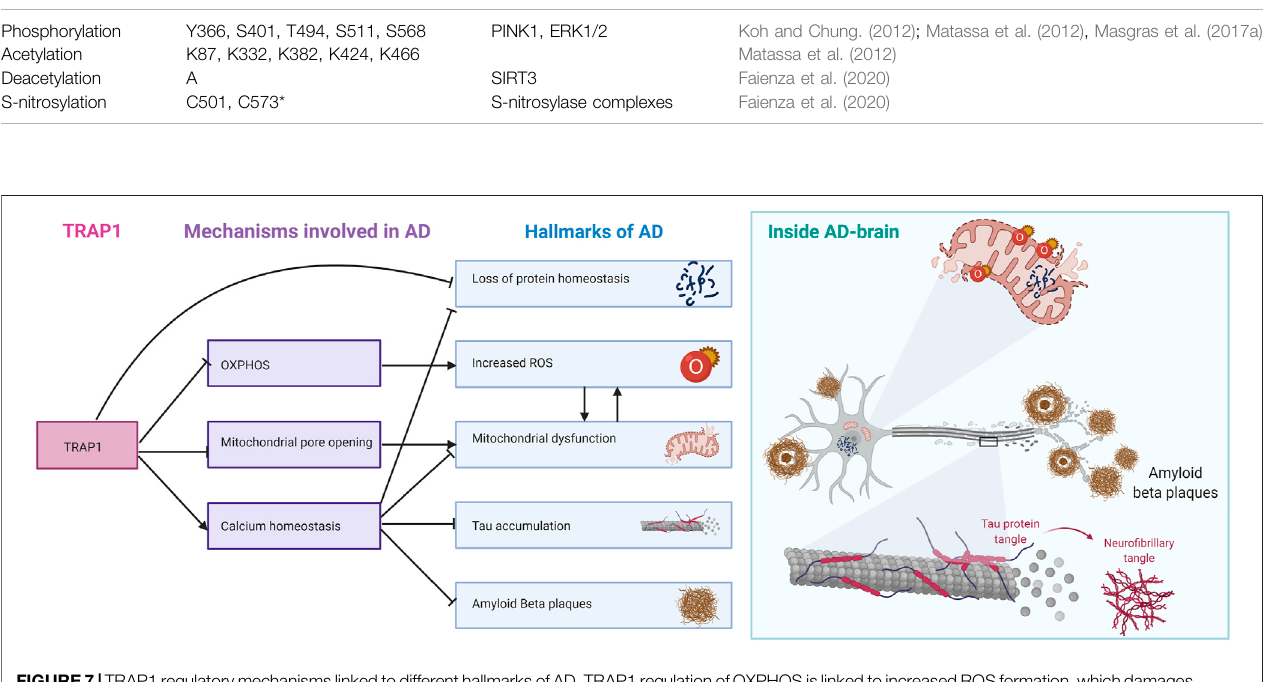
Frontiers in Molecular Biosciences |